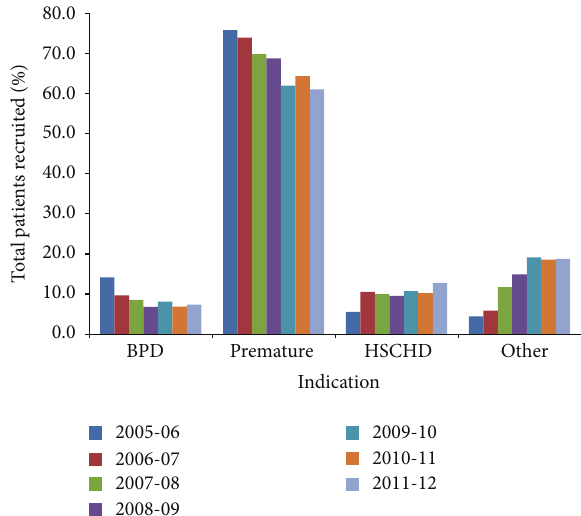
Figure 2: Palivizumab indications across seasons. Indications are subcategorizedintochroniclungdisease(BPD/CLD, 𝑛 = 1048 ),pre- mature ( 𝑛 = 8751 ), hemodynamically significant congenital heart disease (HSCHD, 𝑛 = 1414 ), and “other” ( 𝑛 = 2097 ). The “other” group comprises infants with serious underlying medical